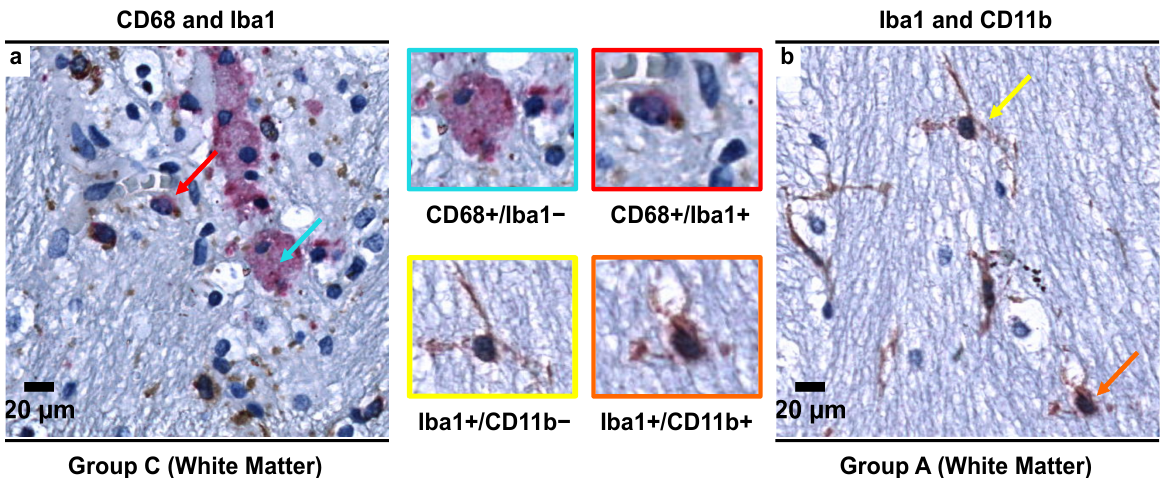
Figure 8. Representative images from double immunohistochemical staining (using two IHC markers in a single slide) showing different microglial subpopulations in the SN region. ( a ) Double CD68/Iba1 IHC staining showing two distinct subpopulations of microglia—CD68+/Iba1 − (blue arrow) and CD68+/Iba1+ (red arrow) in the white matter of the alcoholics (Group C); ( b ) Double Iba1/CD11b IHC staining showing two distinct subpopulations of microglia—Iba1+/CD11b − (yellow arrow) and Iba1+/CD11b+ (orange arrow) in the white matter of the controls (Group A). In both images, brown color (DAB) indicates Iba1+ structures while red color (Permanent red) indicates CD68+ or CD11b+ structures. Original magnification, 400 × . Scale bars, 20 µ